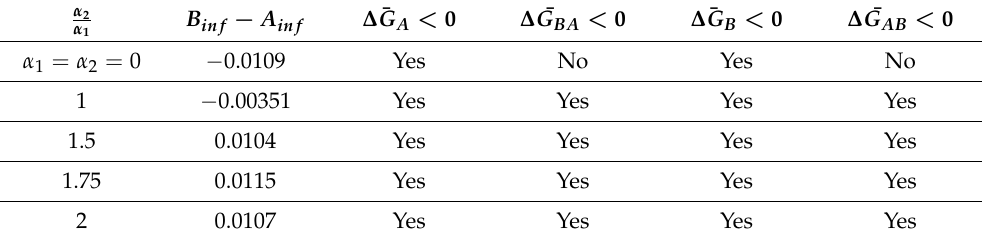
A influenza, and the stability of each pathway. The first row is the control model, with no bridge rates defined. Each successive row increases the mutability of the Type-A to Type-B